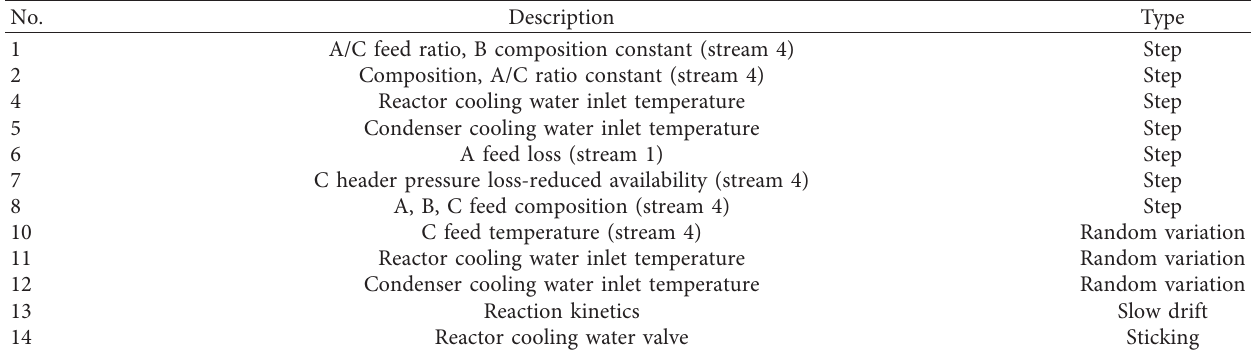
Table 2: The parameters of 6 modes.